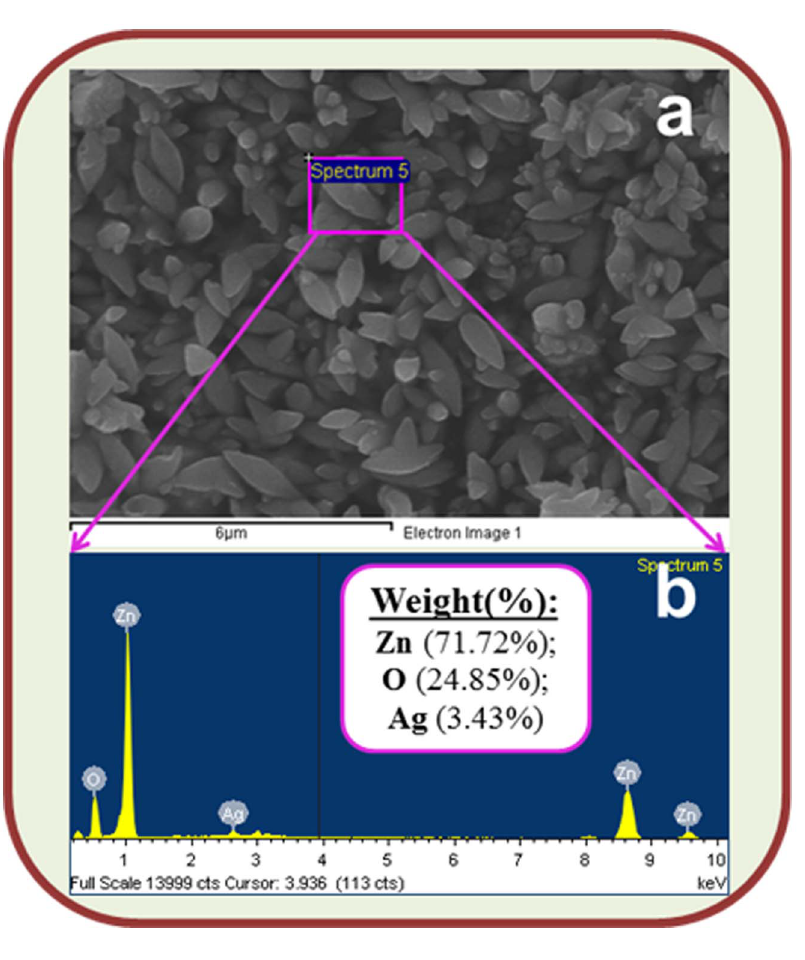
Figure 4. Studies of Elemental Analysis. (a) Ag 2 O 3 -ZnO NCs image of FESEM coupled XEDS and (b) elemental spectrum of XEDS. (Inset: elemental composition weight